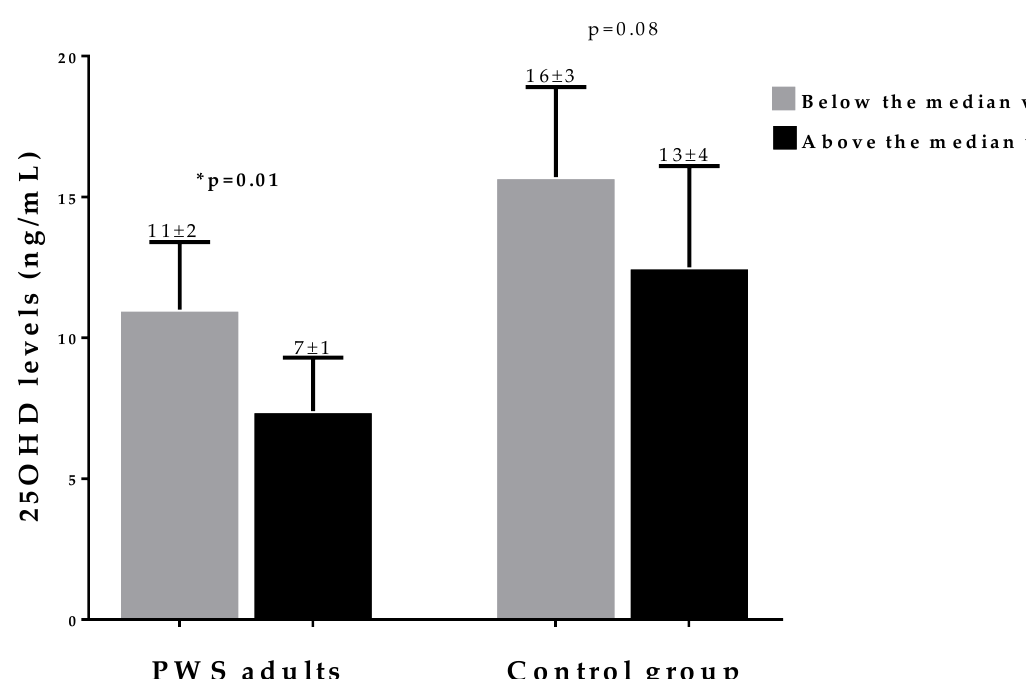
Figure 2. Differences in 25OHD levels in PWS adults and in the control group within the BMI categories (above and below the median values). BMI mean values were 42 and 44 Kg/m 2 in PWS adults and the control group, respectively. The 25OHD levels were lower in the BMI category above the median value in PWS adults only (11 ± 2 vs 7 ± 1 ng/mL, p = 0.01). * A p value < 0.05 means a significant difference. PWS, Prader–Willi syndrome.